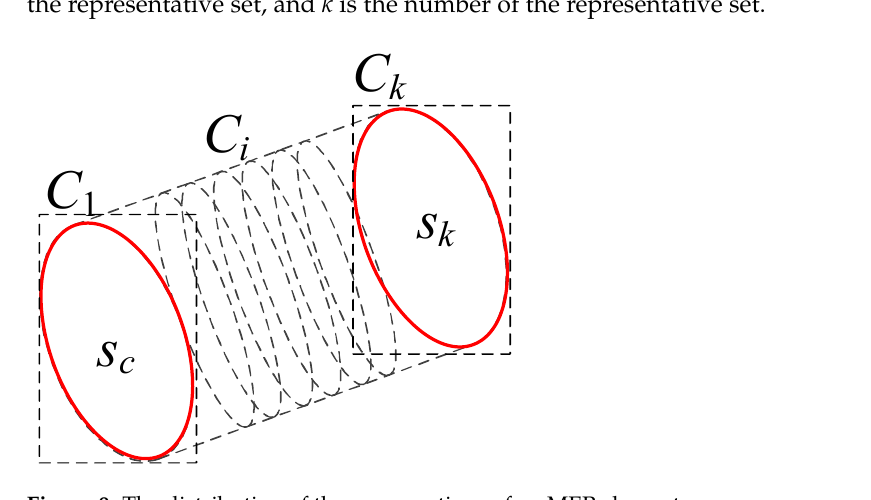
9 of 21 Figure 8. Bowyer–Waston triangulation: ( a ) generate a super triangle; ( b ) generate an initial grid; ( c ) generate Delaunay meshes. In fact, triangular points of an MEP element are divided into two types. One type is the boundary point, and another is the interior point. Boundary points are located on the contour curve where MEP ports are located, and internal points are located on the con-